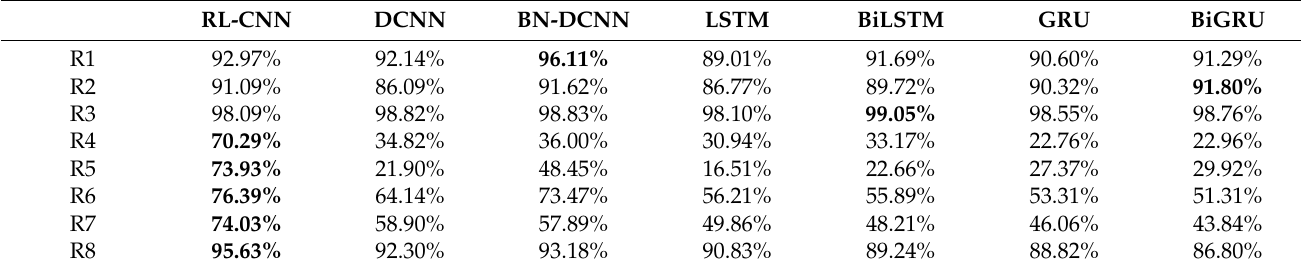
Table 6. The F-score of each radial region.